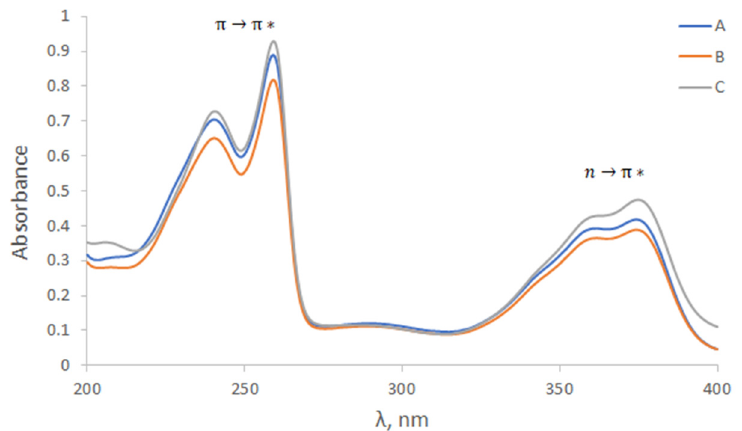
Figure 2. UV-Vis spectra of aqueous solutions of dioxidine: A—pharmacopoeia dioxidine (0.0029 mg/mL), B—cryochemically modified dioxidine obtained at a zero carrier gas flow (0.0028 mg/mL), C—cryochemically modified dioxidine obtained at a carrier gas flow of 6.97 × 10 17 molec s − 1 cm 2 (0.0031